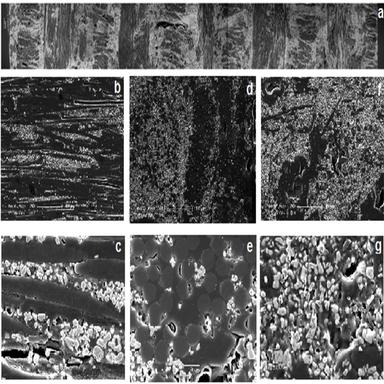
SEM characterisation of Cf-HfB2 powder composite after C CVI and machining. (a) Across the entire thickness, (b,c) 0° orientation ply, (d,e) 90° orientation ply, (f,g) random orientation ply.